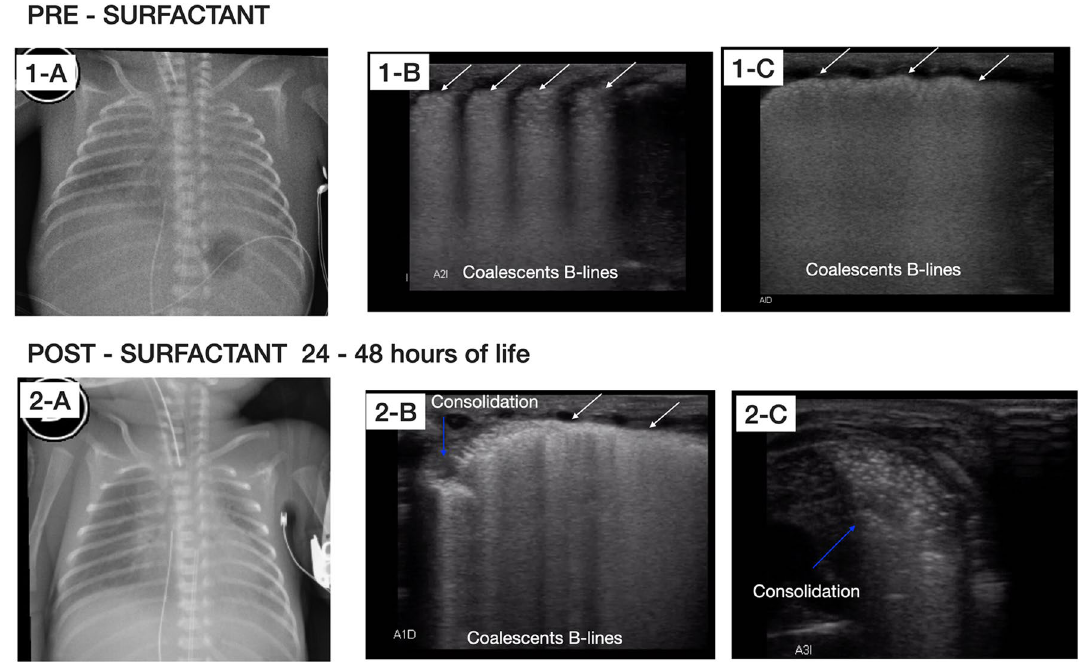
Fig. 2 Radiographic and LU examination pre-surfactant administration and after 24–48 h of life. Top: chest X-ray and LU examination after birth pre-surfactant administration. 1-A Chest X-ray shows poorly inflated lungs with ground glass shadowing widespread in both hemithorax with obliteration of cardiac silhouette. 1-B and 1-C LU examinations in longitudinal and oblique view, respectively, show irregularity of the pleural line (white arrows), subpleural consolidation and widespread appearance of “white lung” on both lung fields without spared areas. Bottom: chest X-ray and LU examinations performed after 24–48 h of life. 2-A chest X-ray shows increased interstitial infiltrate. 2-B and 2-C LU examinations in oblique view, show severe deterioration of lung aeration, presence of multiple bilateral consolidations (blue arrows), air bronchograms, and coalescent B-lines without spared